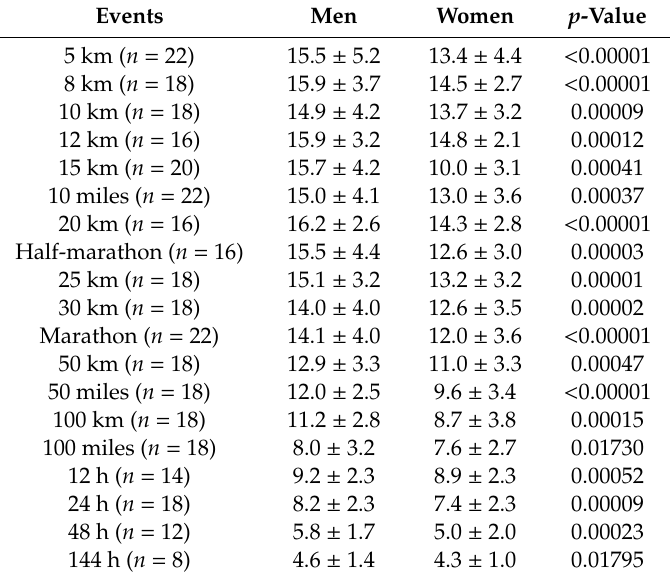
Table 1. Average running speed (km · h − 1 ) of the American masters road running records by event. Data expressed as mean and standard deviation ( ±